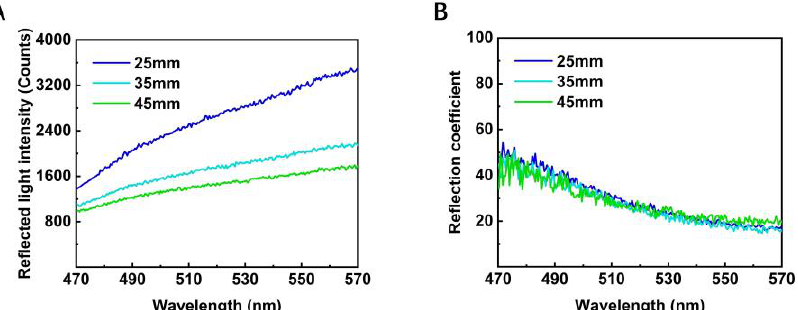
Figure 3. We chose nylon, one of the five materials, as a representative to show the difference in distance between the two data forms. ( A ) Light intensity 𝐼 𝑟𝑒𝑓 of nylon collected at different distances. ( B ) Reflection coefficient 𝑅 𝐶 of nylon collected at different distances.